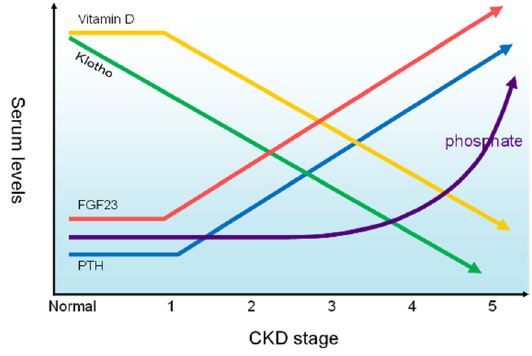
Figure 1. Changes in biochemical markers of MBD during the progression of CKD. Reproduced with permission from John, GB et al., Am J Kidney Dis, published by Elsevier, 2011.